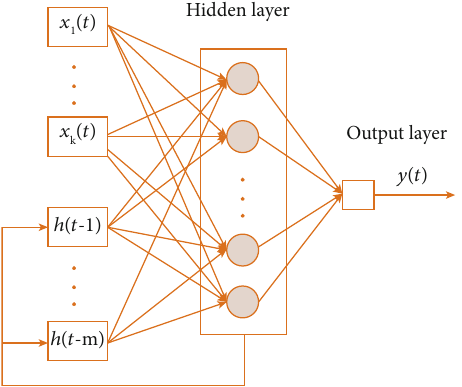
Figure 3: Schematic of Elman neural network [27].